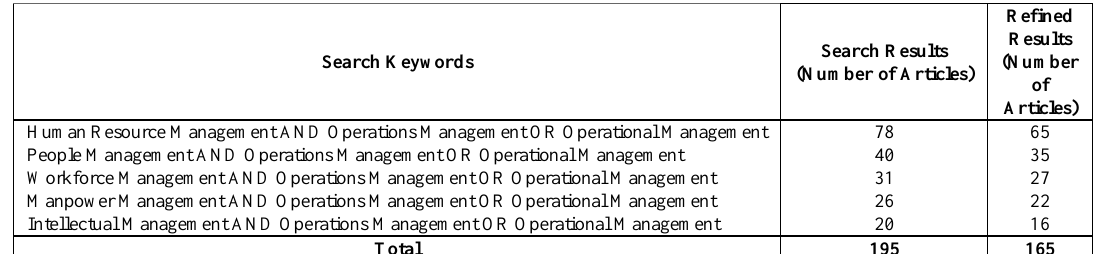
Table 1. Keyword search results: intellectual capital and operational